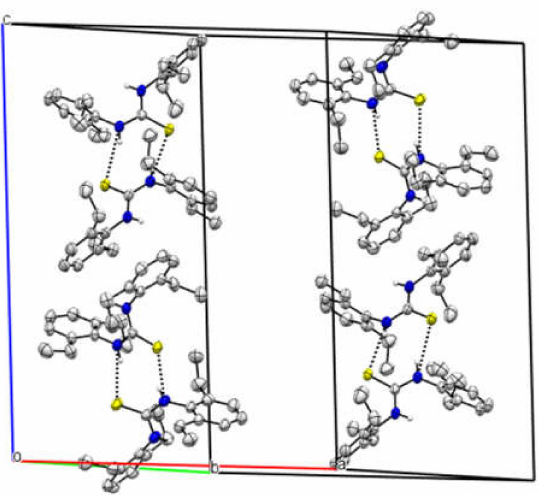
Figure 2. The partial packing figure of 1,3-bis(2,6-diethylphenyl)thiourea ligand along a, b and c axes (which shows the intermolecular H-bonds). Only N-H hydrogens are shown. Color scheme: S = yellow; N = blue; C = grey; and H =